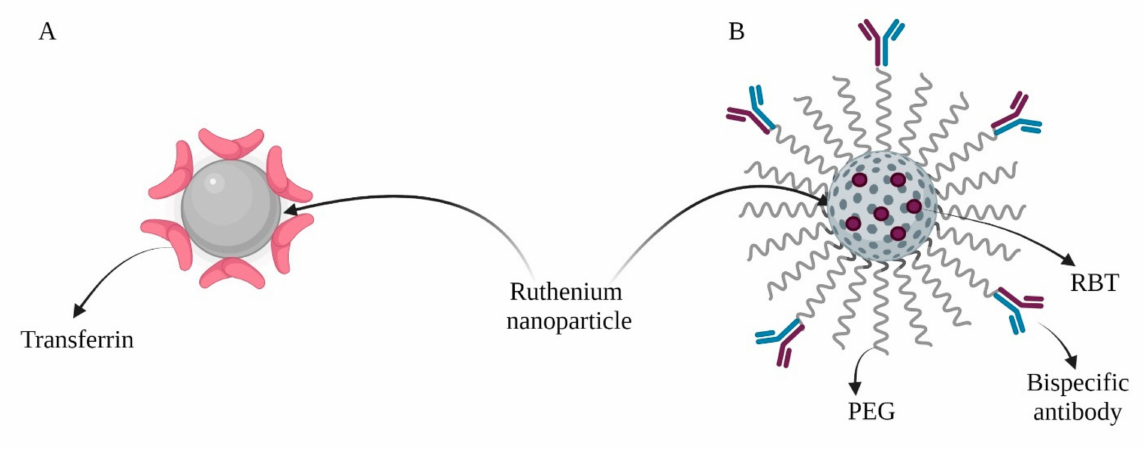
Figure 4. Combined nanoparticles: ( A ) Tf-Ru NPs; ( B ) HMRu NPs, (created using BioRender.com, access date: 6 May